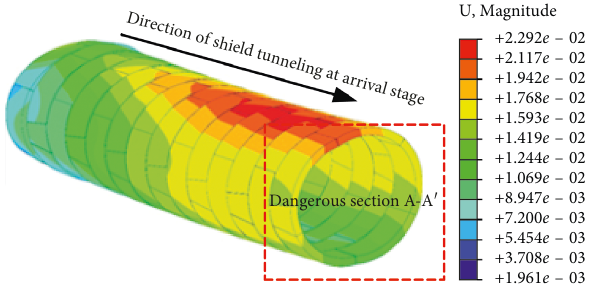
Figure 19: Segment deformation nephogram at the reinforcement depth of H